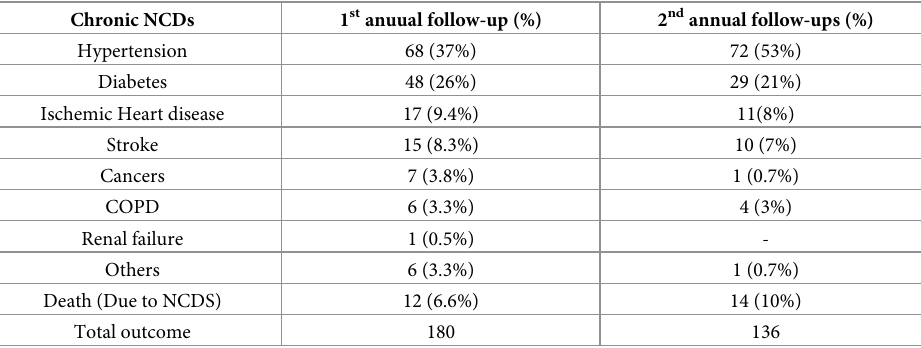
Table 7. The most common chronic NCDs diagnosed during the first and second annual